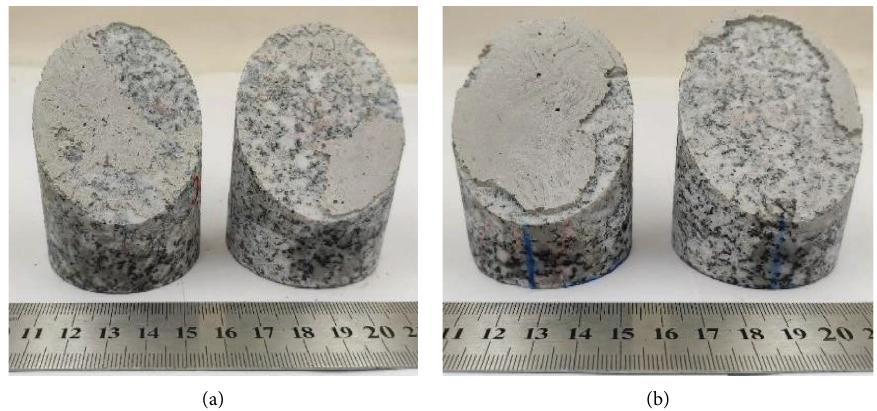
Figure 30: Damaged cement-repaired samples with diferent crack widths at day 28: 1 mm (a) and 3 mm(b).